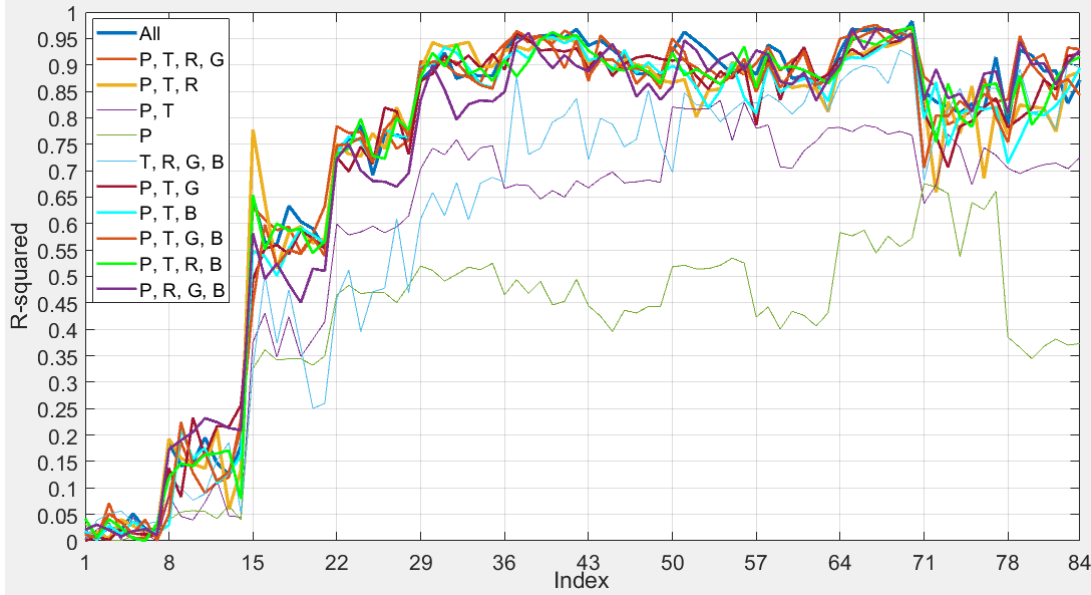
Figure 13. R 2 values for neural network regression models for Δ P with varying input variables.